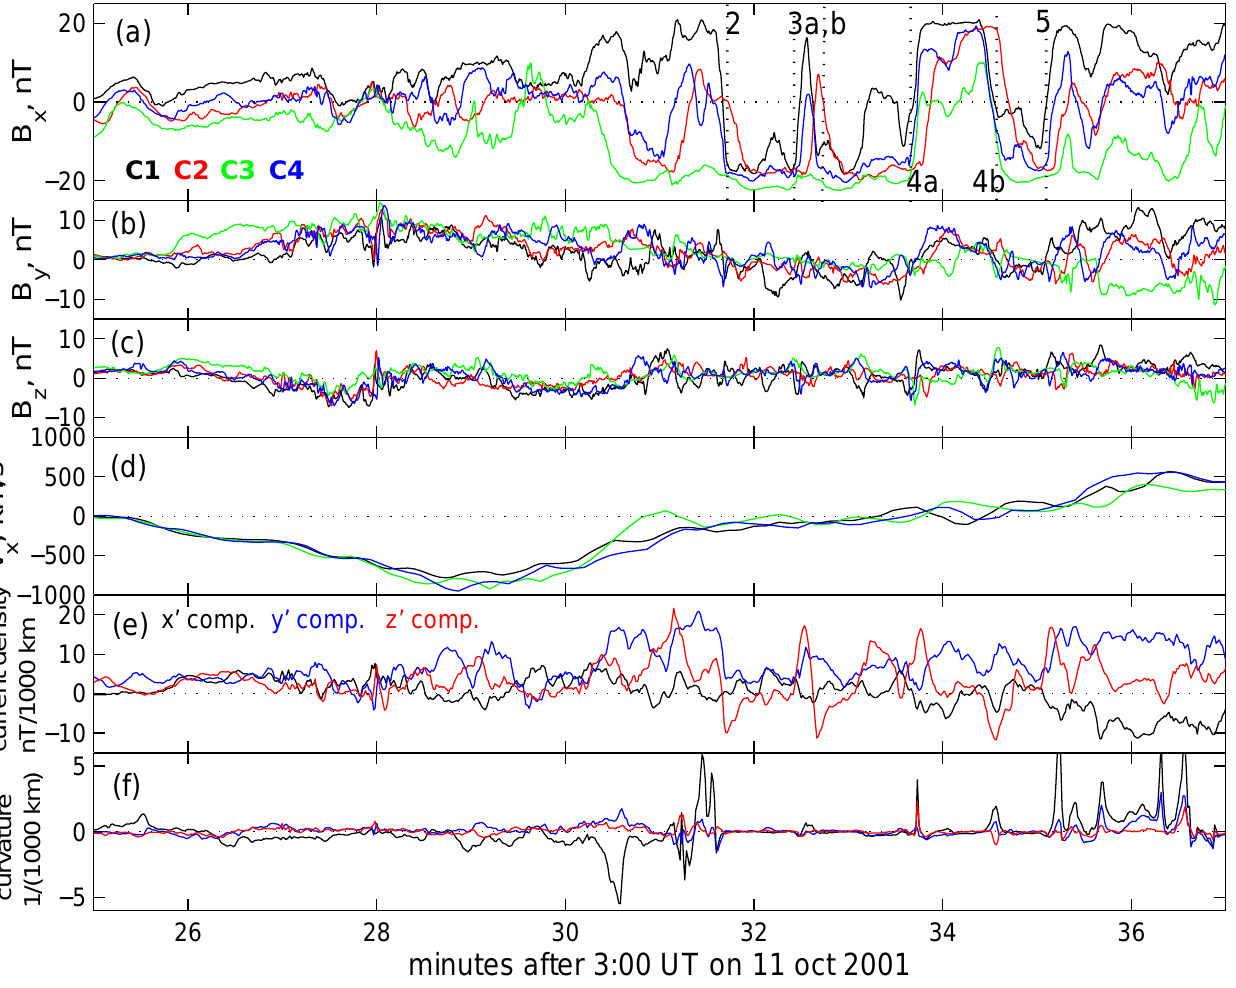
Fig. 5. Observed and calculated quantities during the event, given in the x 0 y 0 z 0 coordinate system defined in Sect. 2.4. (a–c) Magnetic field components. Data from Cluster 1 in black, C2 in red, C3 in green and C4 in blue. (d) x component of proton flow velocity, colours as in (a–c). Proton data from C2 is missing because its CIS instrument group is broken. (e) Current density and (f) curvature vector at the Cluster barycentre. x 0 component in black, y 0 in blue and z 0 in